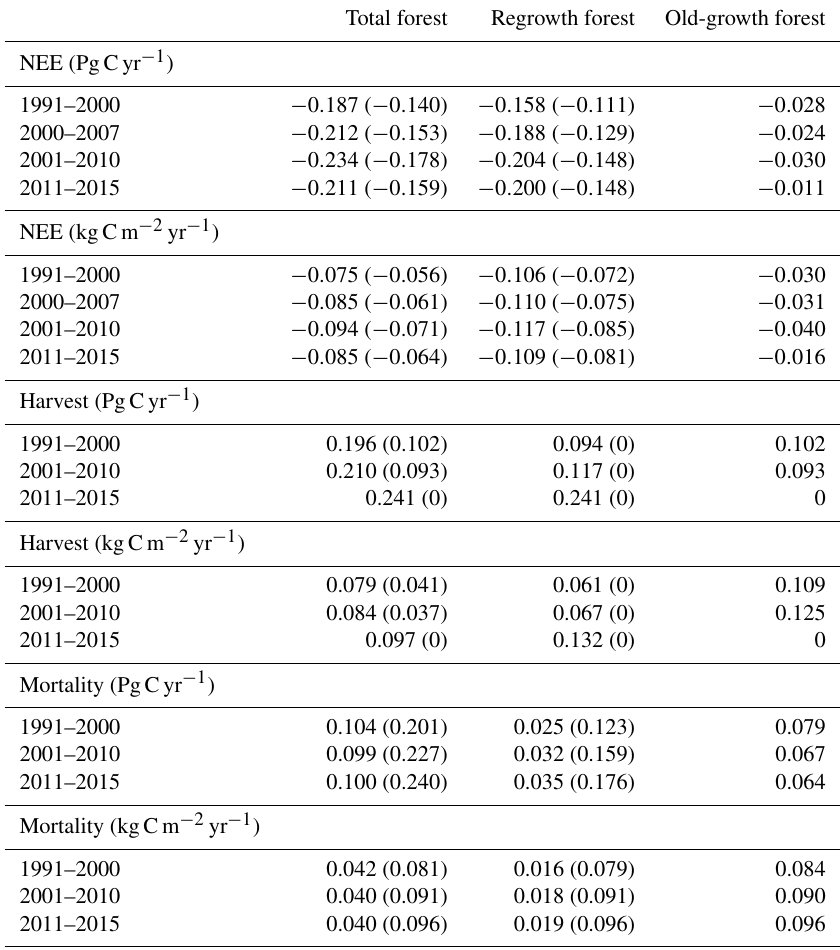
Table 6. Net ecosystem exchange (NEE), harvested carbon, and natural mortality in European forests 1 separated into regrowth and old- growth